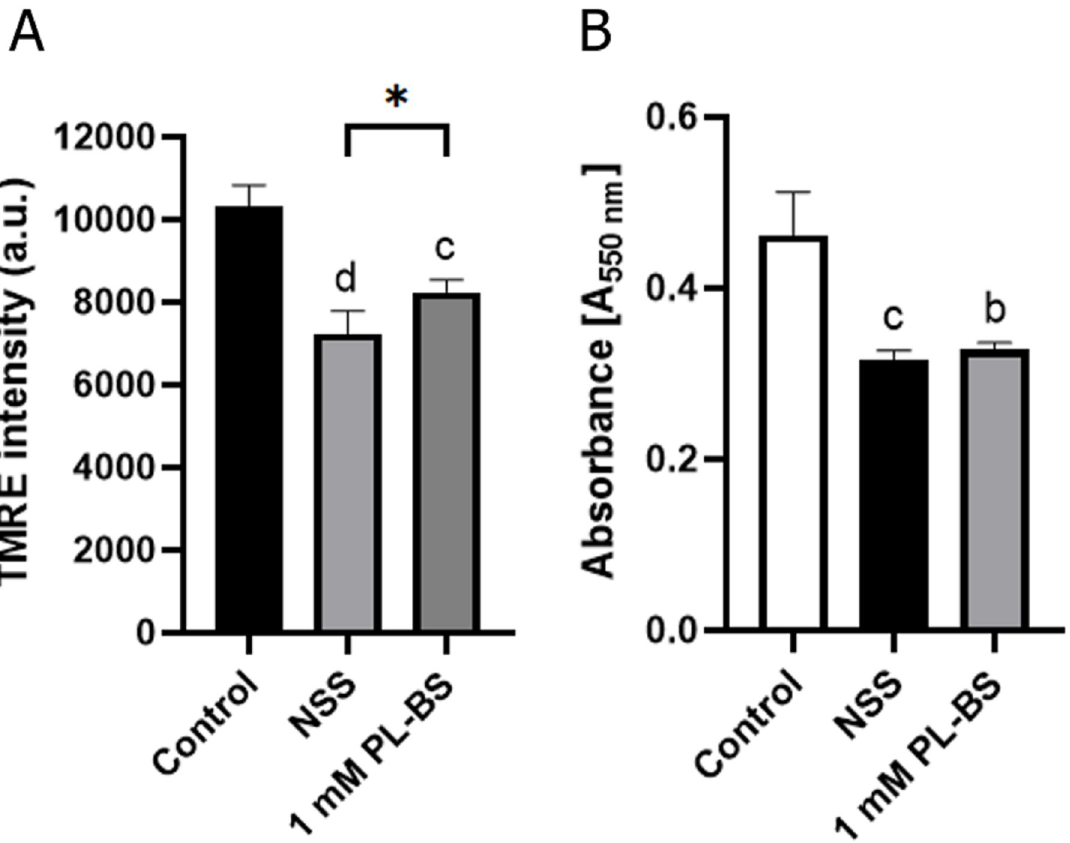
Fig 4. Comparison of mitochondrial membrane potential and proliferation of canine adipose-derived mesenchymal stem cells in different conditions. (A) Based on TMRE assay, the mitochondrial membrane potential (MMP) of cAD-MSCs stored in both NSS and 1 mM PL-BS for 6 hours, was significantly lower than that in the control group, (p < 0.0001 and p < 0.001, respectively). However, the MMP of cAD-MSCs stored in 1 mM PL-BS was significantly higher than that in NSS (p < 0.05). (B) According to MTT assay, the proliferation rate of cAD-MSCs stored in NSS or 1 mM PL-BS was significantly lower than that in non-storage cells (p < 0.01 and p < 0.001, respectively). Remark symbols; Asterisk represents a significant difference (p < 0.05). The lowercase letters b, c, and d indicate significant difference from the control group; b = p < 0.01, c = p < 0.001, and d = p <